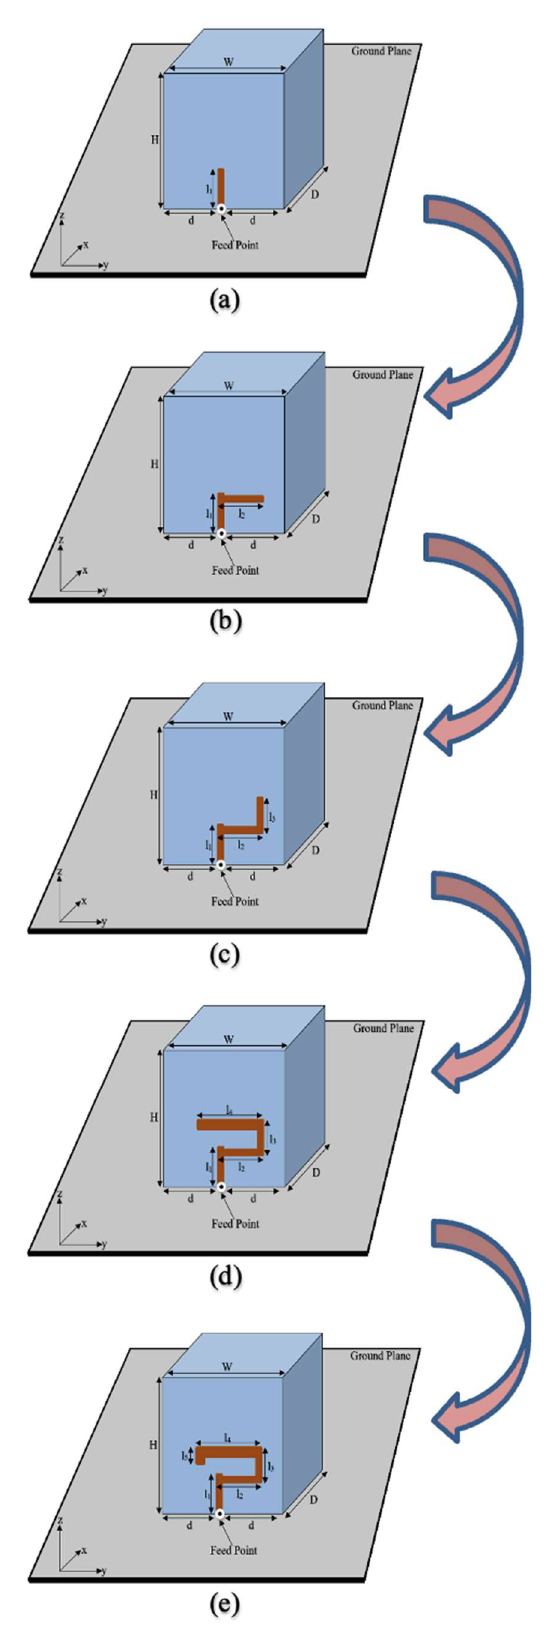
Figure 2. Step by step development of the CP 5G RDRA. ( a ) Geometry 1; ( b ) Geometry 2; ( c ) Geometry 3; ( d ) Geometry 4; ( e ) Geometry of the Proposed CP 5G RDRA.